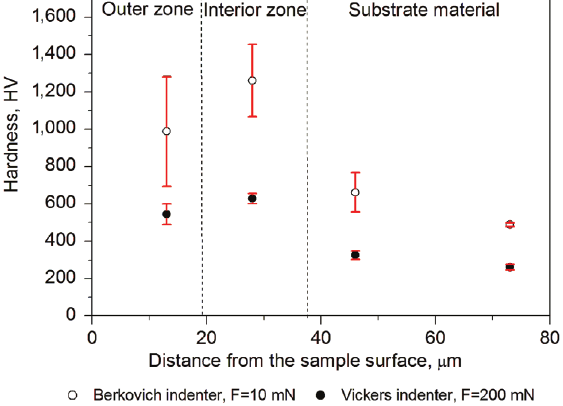
Figure 14: The microhardness and nanohardness range, measurement on the cross section of the aluminide coating created with the CVD method, process time 8